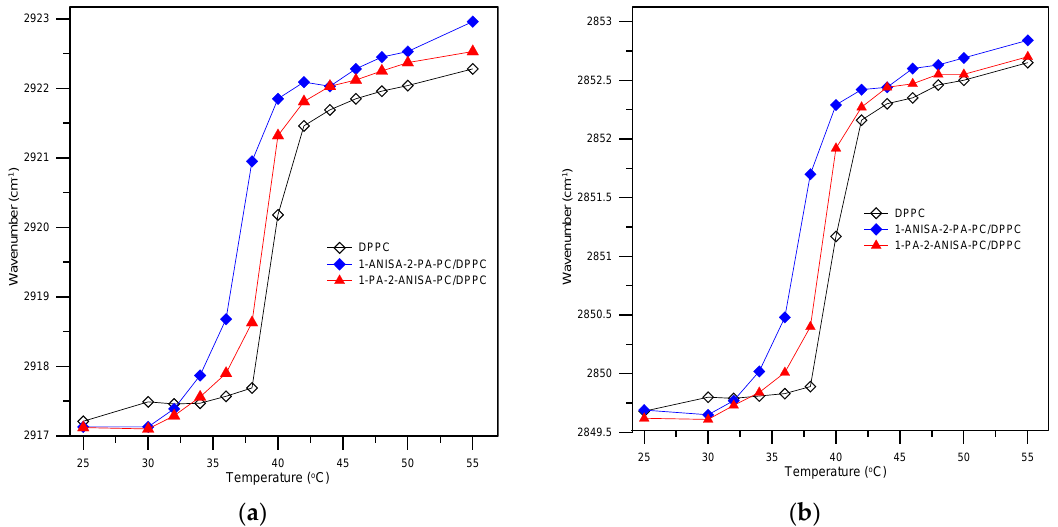
Figure 6. Temperature dependence of the asymmetric ( a ) and symmetric ( b ) CH 2 stretching mode in the presence and absence of conjugates of anisic acid with phospatidylcholine (1-ANISA-2-PA-PC and 1-PA-2-ANISA-PC) for DPPC bilayers.